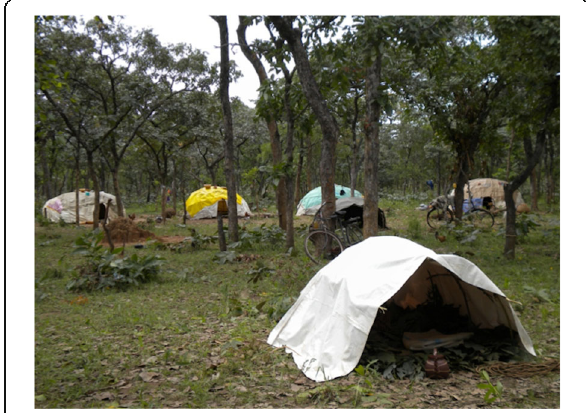
Figure 3 Temporary housing erected by families during the mass immigration event of April to May 2011